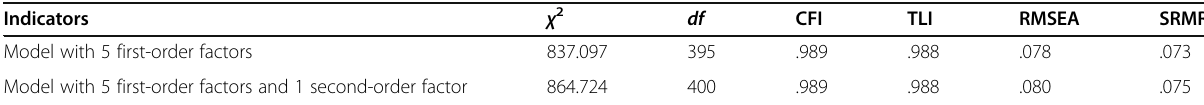
Table 7 Solutions of confirmatory factor analyses Indicators χ 2 Model with 5 first-order factors Model with 5 first-order factors and 1 second-order